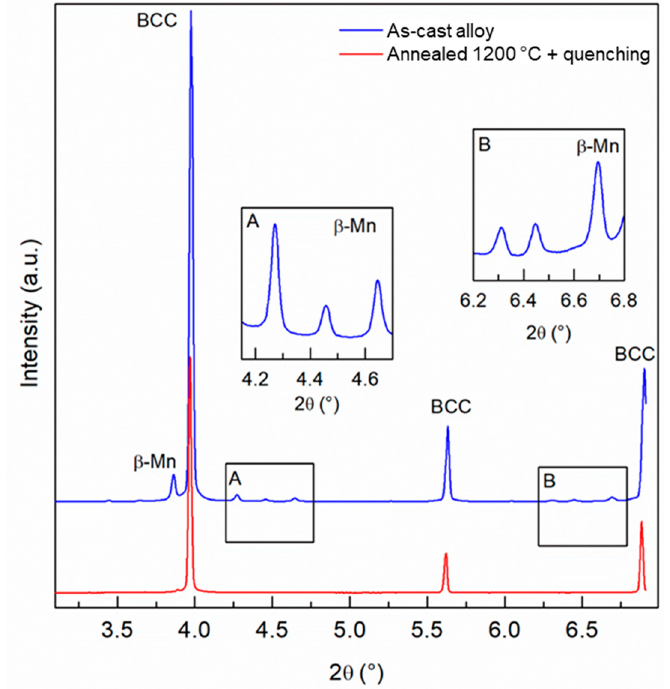
Figure 3. HEXRD patterns for the as ‐ cast and annealed Al 10 Cr 30 Fe 25 Mn 30 Ti 5 HEA at 1200 °C, and subsequently quenched in water.